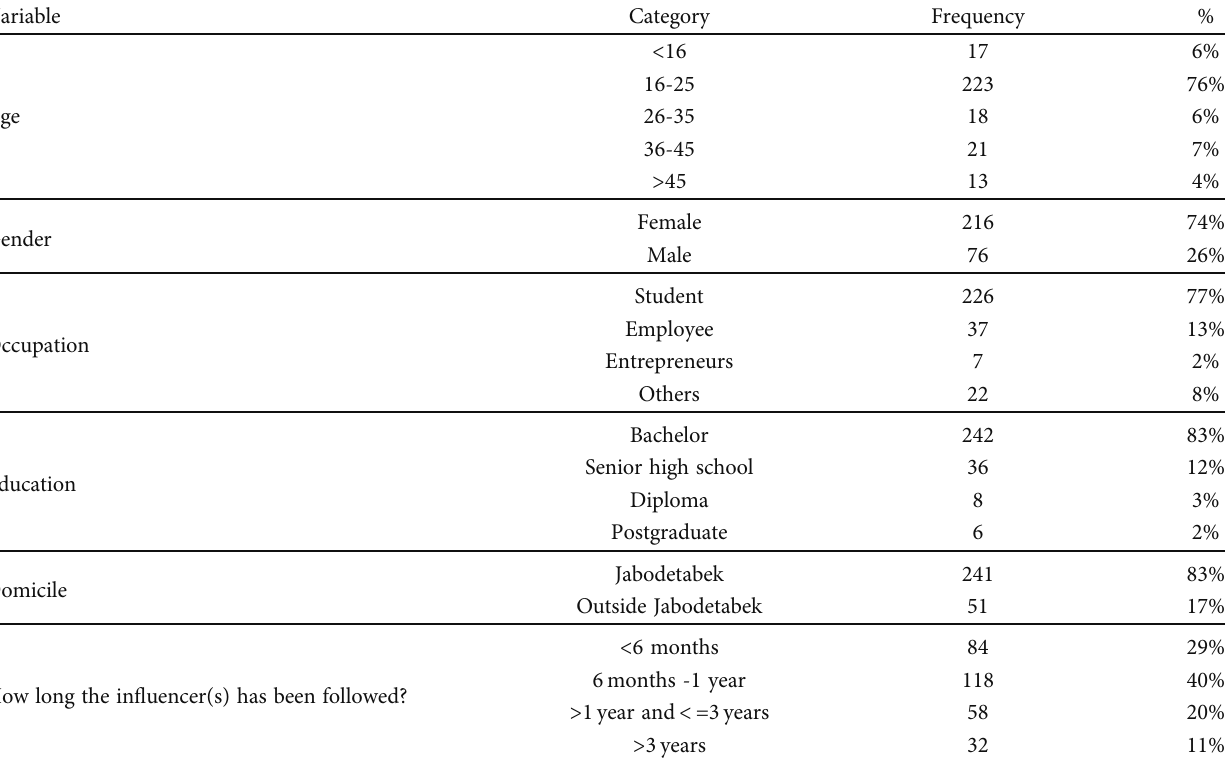
Table 1: Social demographic